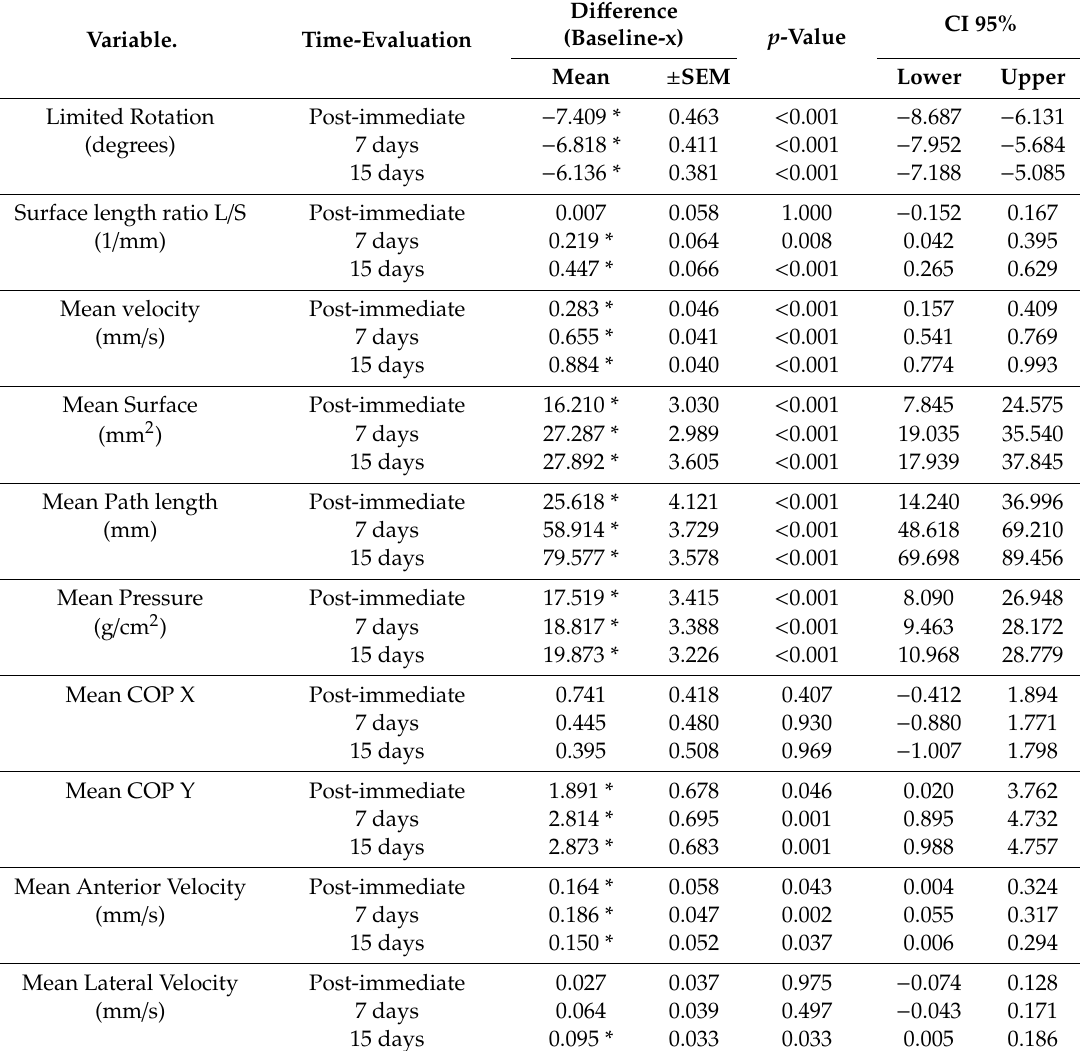
Table 4. Interaction between factors (time * group) showing the experimental group data di ff erences in the pairs of means by the time factor (post hoc Sidak